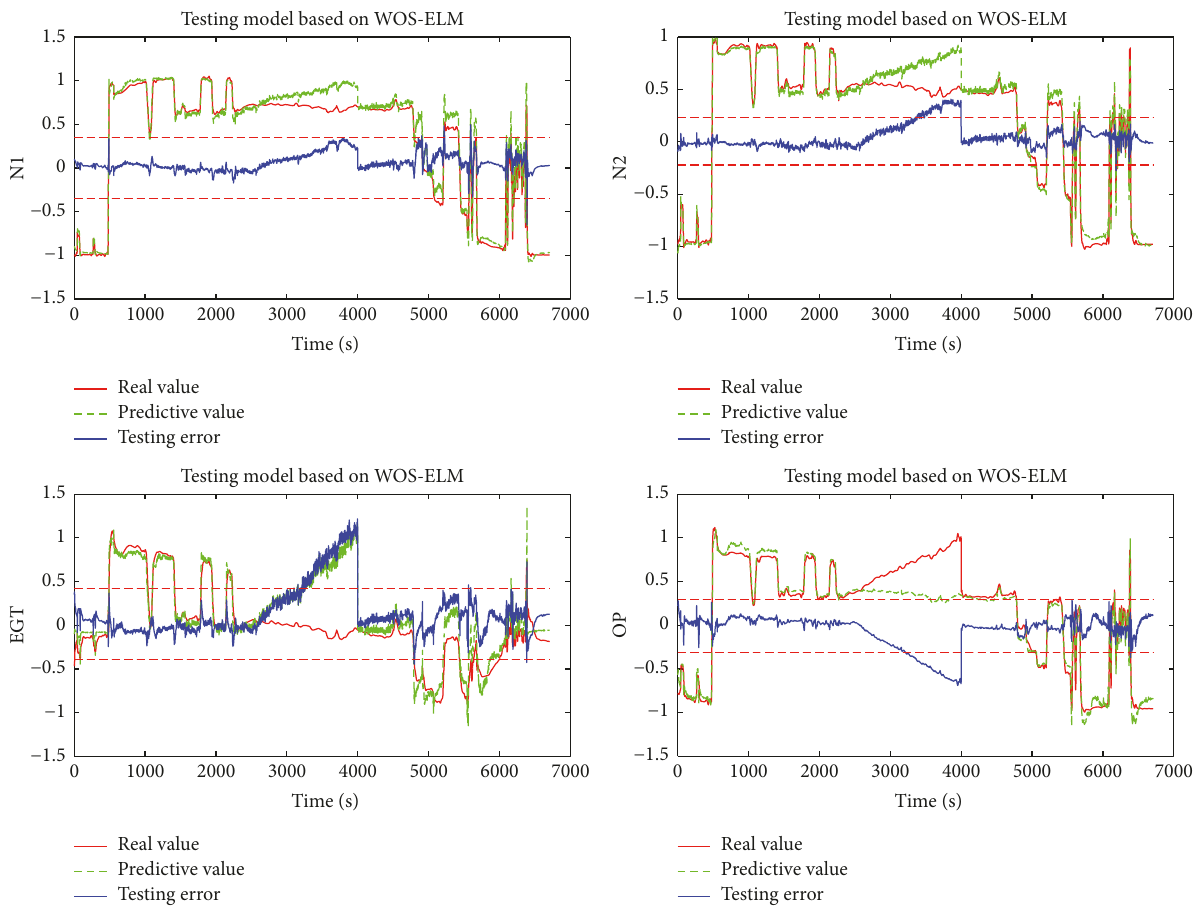
Figure 10: Spatial redundancy results for soft